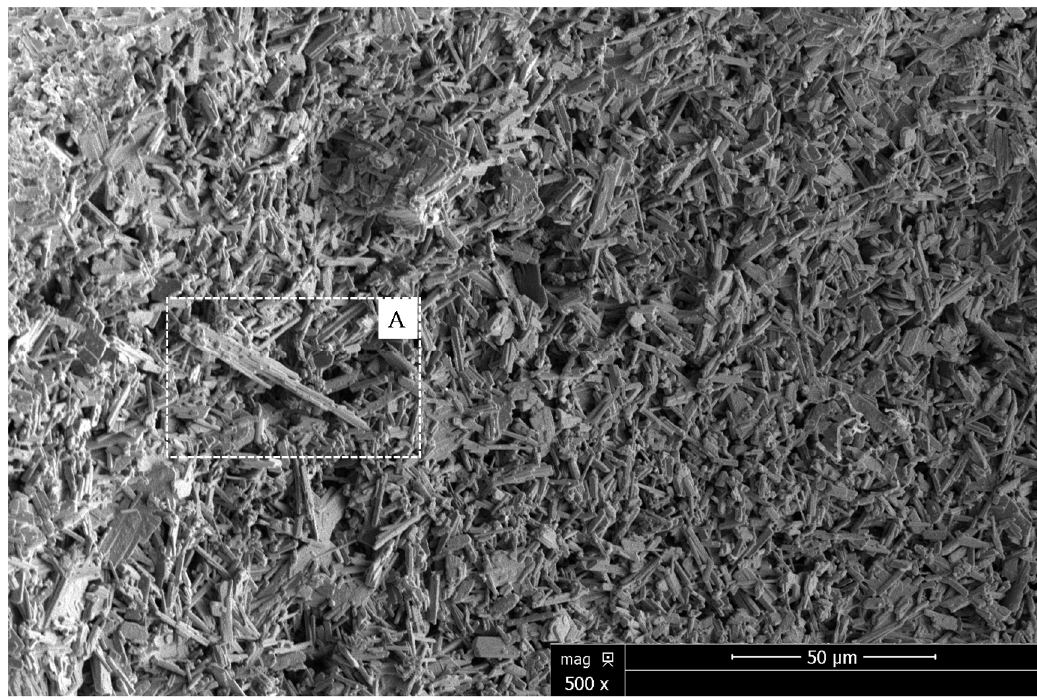
Figure 7. SEM scanning image of S1 (500 times).